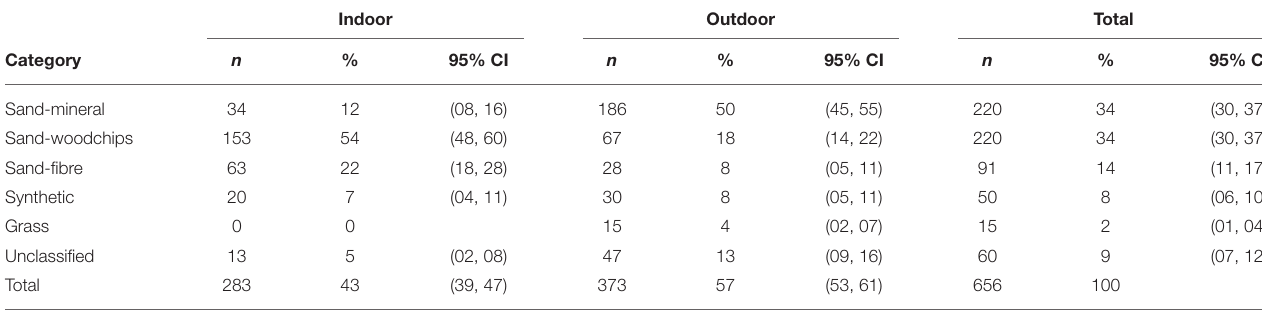
TABLE 1 | Arenas by indoor/outdoor and top-layer category, including numbers, proportions and their 95% confidence intervals (95%CI).